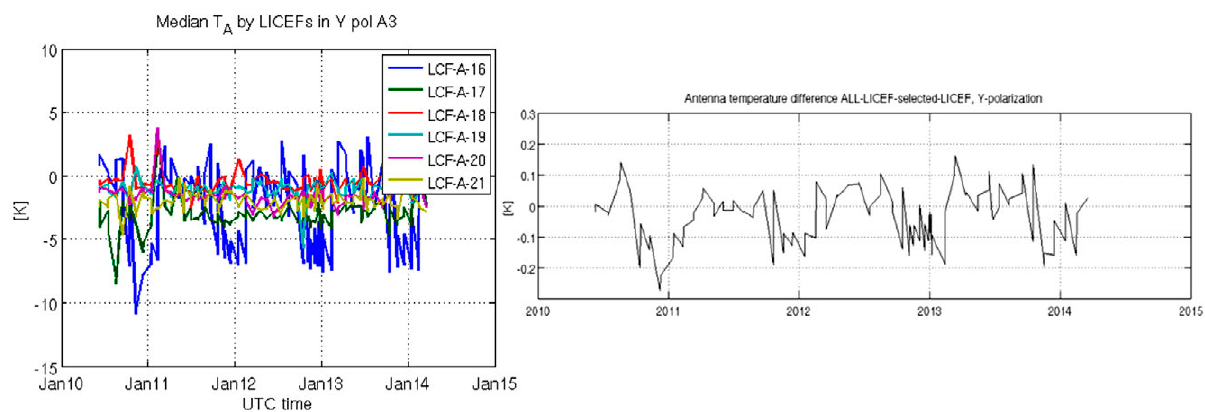
Fig. 3. – Left, antenna temperature variations corresponding to receivers located in segment A1 in Y-polarization when compared with the antenna temperature averaged from all the LICEFs. Anomalous drifts can be clearly observed in some periods of the long-term dataset for receiver LCF-A-16. Right, antenna temperature difference between ALL-LICEF and selected-LICEF modes.